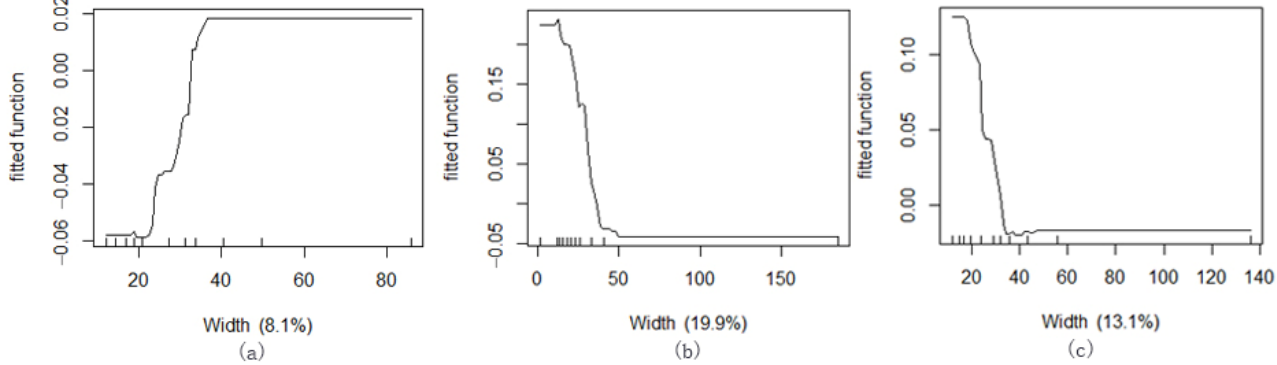
Figure 12. ME curve of BRT between the GWd factor and Ta of green corridors: ( a ) block N1, ( b ) block N2 and ( c ) block N3.